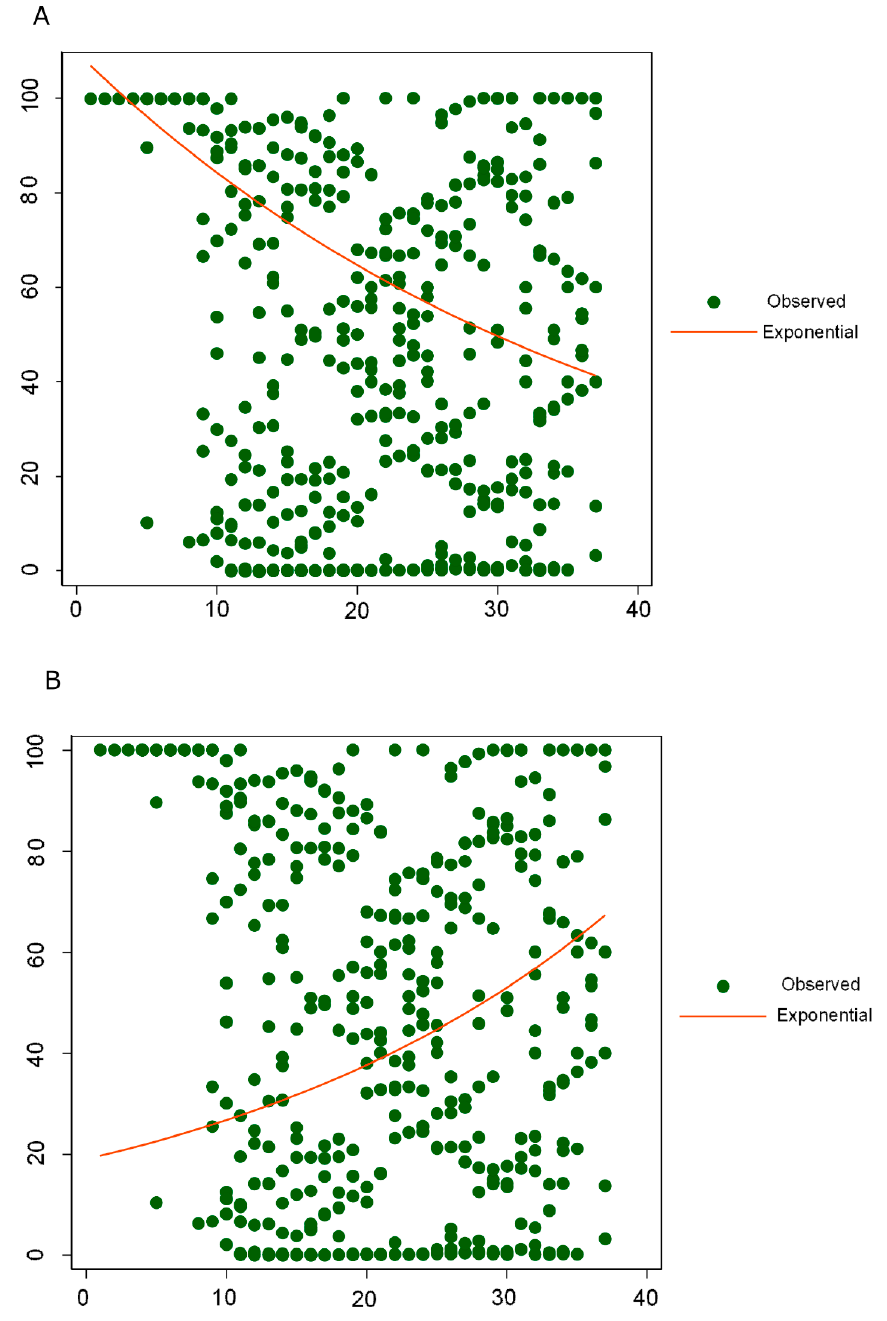
Figure 4. Exponential linear regression for aa combinations in positions 203 and 204 of the nucleo- capsid protein. ( A ) Exponential linear regression for RG combination in positions 203 + 204 of the mucleocapsid protein. The exponential curve shows an overall decrease of the RG combination over time. b = − 0.02, Y = 109.7 × (e^( − 0.0264 × epiweek)) or ln(Y) = ln(109.7) + ( − 0.0264 × epiweek), R2 = 88.7%; ( B ) Exponential linear regression for KR combination in positions 203 + 204 of the nucleocapsid protein. The exponential curve shows an overall increase of the KR combination over time. b = 0.03, Y = 19 × (e^(0.0343 × epiweek)) or ln(Y) = ln(19) + (0.0343 × epiweek), R2 = 73.2%. The x -axis represents epidemiological weeks and the y -axis represents frequency percentage of observed combinations. Green dot, observed aa combinations in positions 203 and 204 of the nucleocapsid protein; red line, exponential curve; B, slope; R2, relative predictive power. In North America, the frequency increased until epiweek 23 (48.7%), and then de- creased until epiweek 26, stabilizing at a frequency of around 20%. As 92% of the North